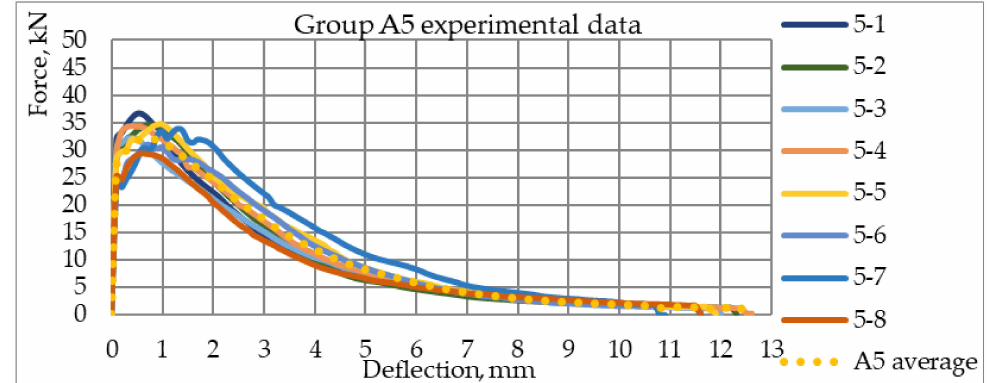
Figure 19. Load—sample center vertical deflection graphs for the specimens in Group A5.